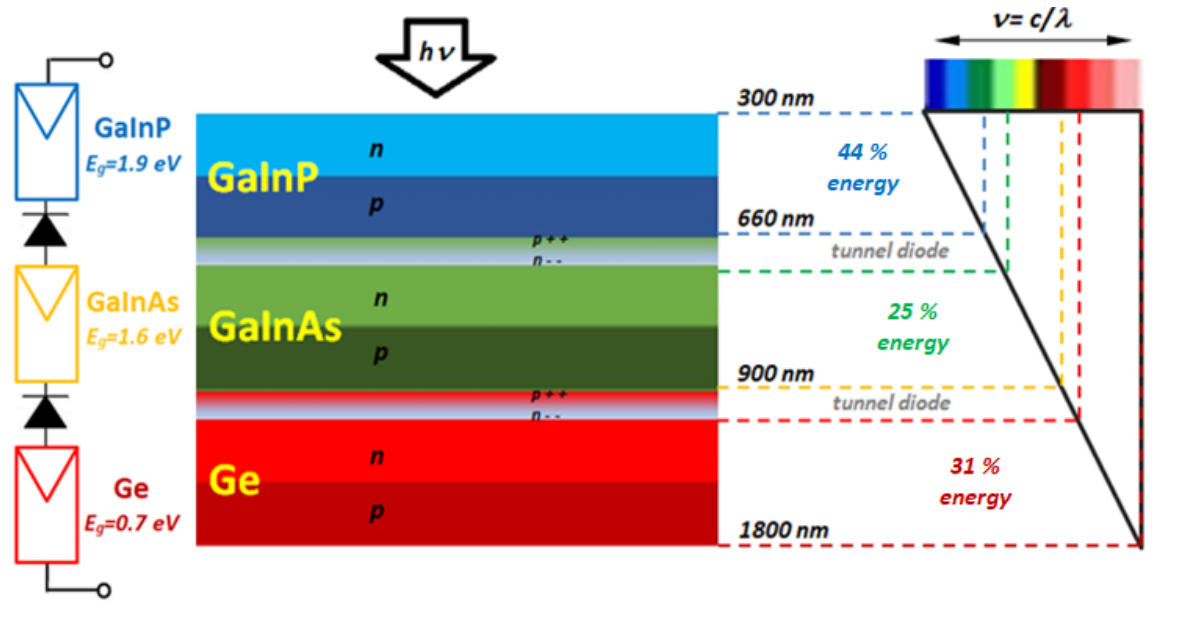
Figure 2. Structure and equivalent model of a single 3J cell and the ranges of absorbed radiation.